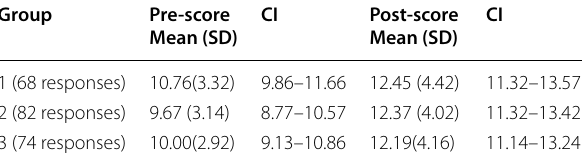
SD standard deviation, CI confidence interval